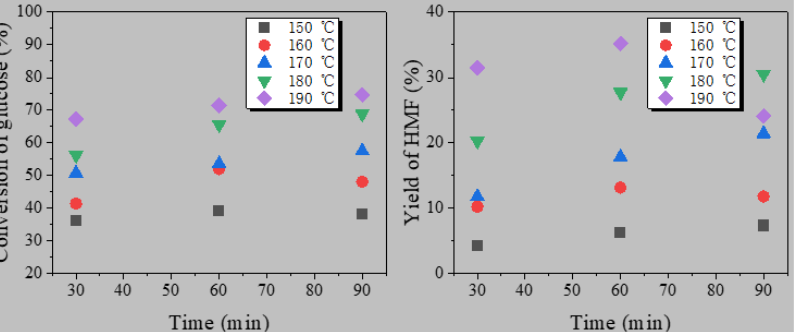
Figure 6. The effect of temperature and time on conversion of glucose to HMF with pressure reduction over SO 42 − /B 2 O 3 /ZrO 2.